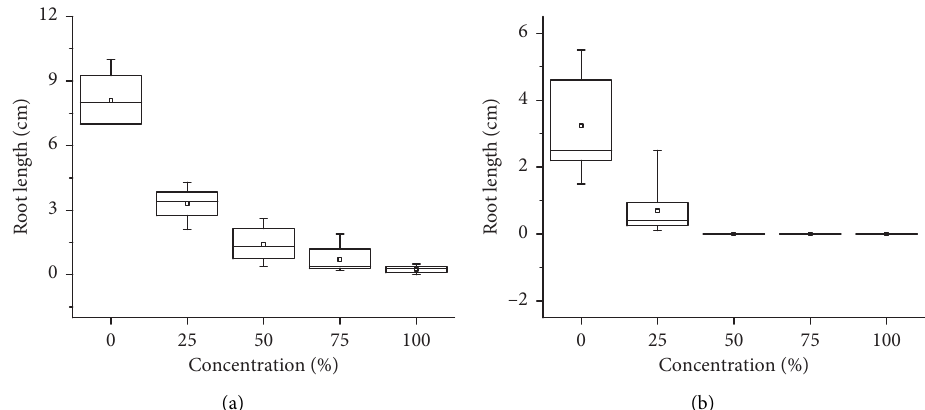
Figure 3: Root length of germinated P. vulgaris (a) and O. sativa (b) seedlings in a laboratory experiment after 7 and 14 days of treatment with S. suaveolens extracts, respectively.